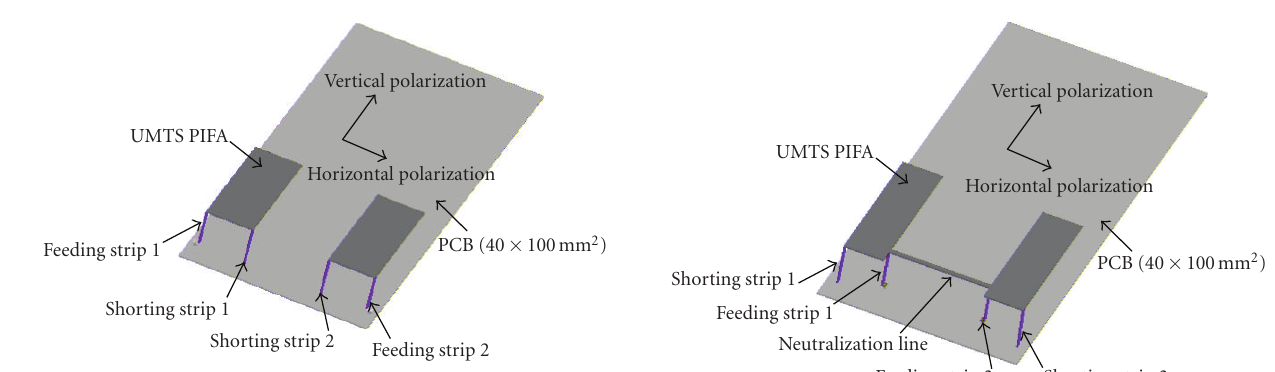
Figure 1: 3D view of the initial two-antenna system.